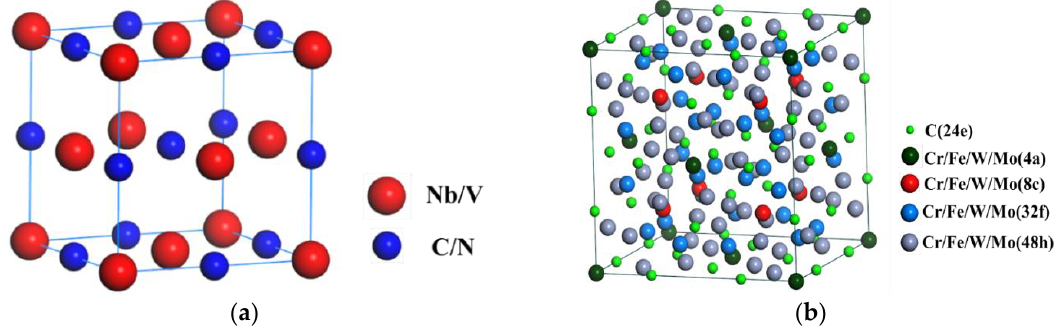
Figure 14. Structure diagram of M 23 C 6 precipitate and MX precipitates: ( a ) crystal structure of MX precipitate, ( b ) crystal structure of M 23 C 6 precipitate.